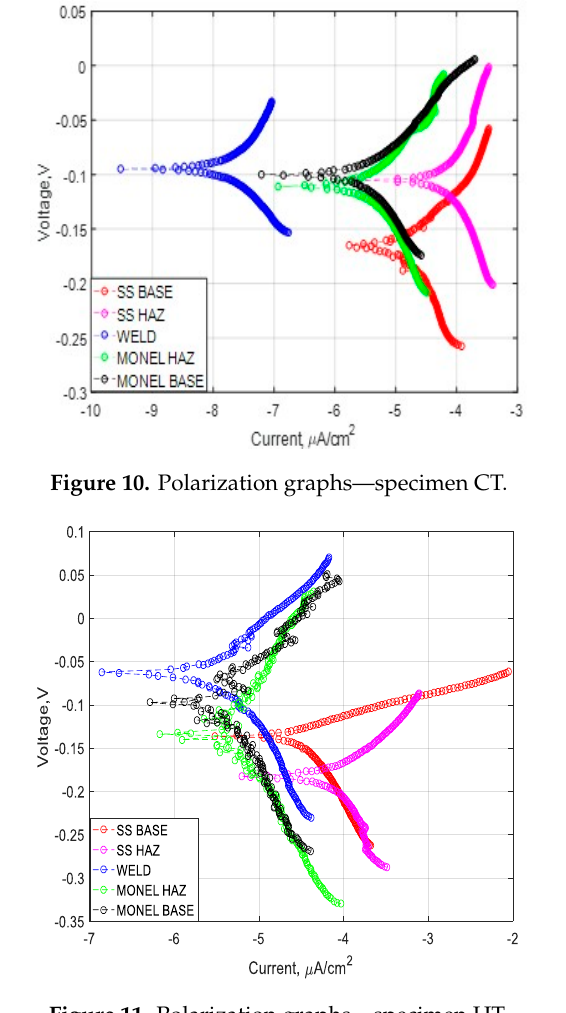
Figure 11. Polarization graphs — specimen HT.